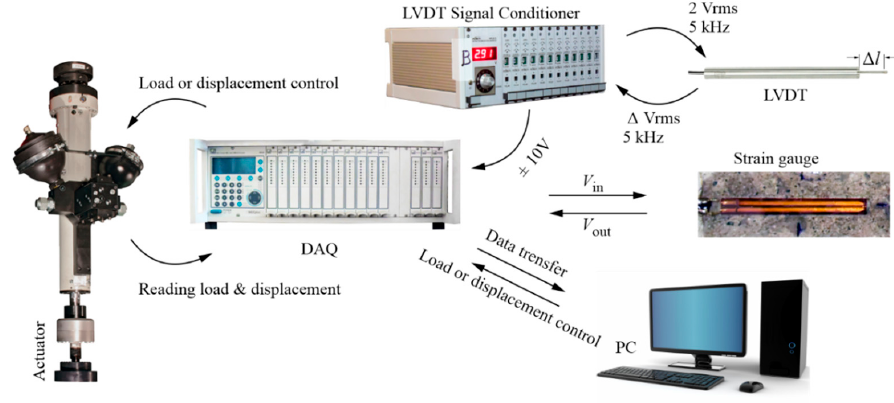
Figure 12. Configuration of the measurement chains for deflection, strains, and curvature.